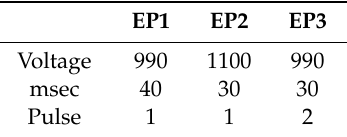
Table 2. Electroporation protocols tested to transfect MSCs. EP1 EP2 EP3 Voltage 990 1100 990 msec 40 30 30 Pulse 1 1